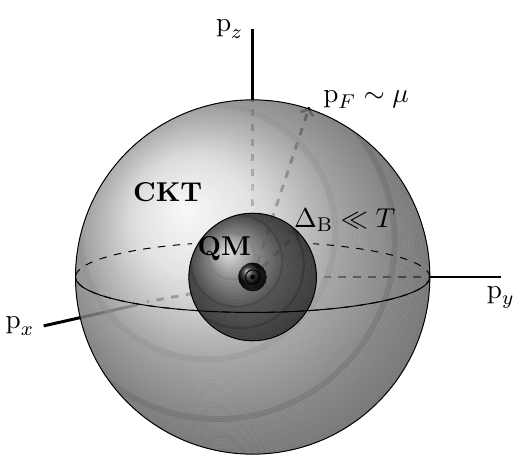
µ , the quasi-particles occupy the states inside the ≪ p = ∆ B are excluded. In this region, the quantum | | . µ , chiral kinetic theory is a valid picture in the range p | |